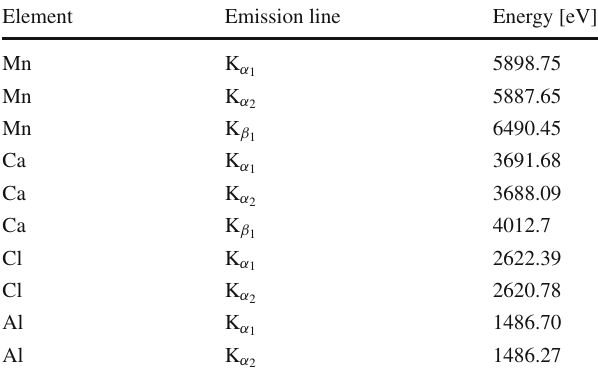
Table 1 The most intense X-ray lines available in our set-up